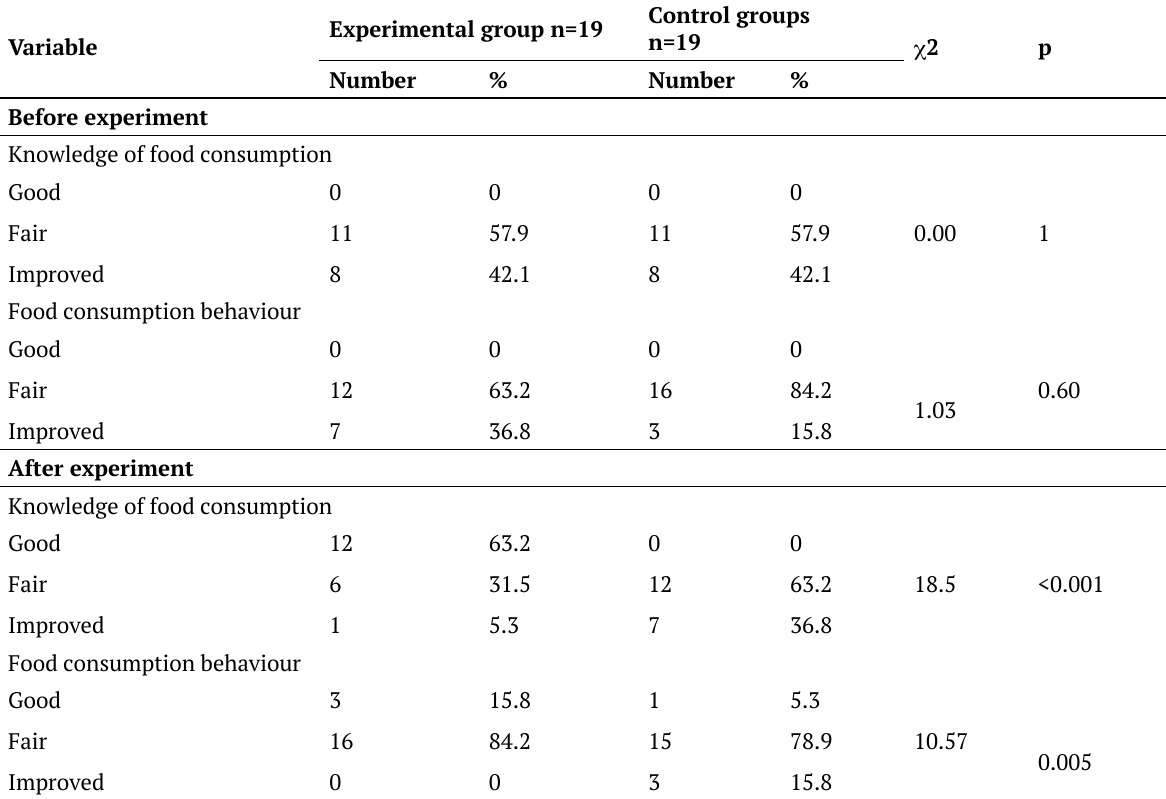
Table 4. Knowledge of food consumption and food consumption behaviour in experimental and control groups.